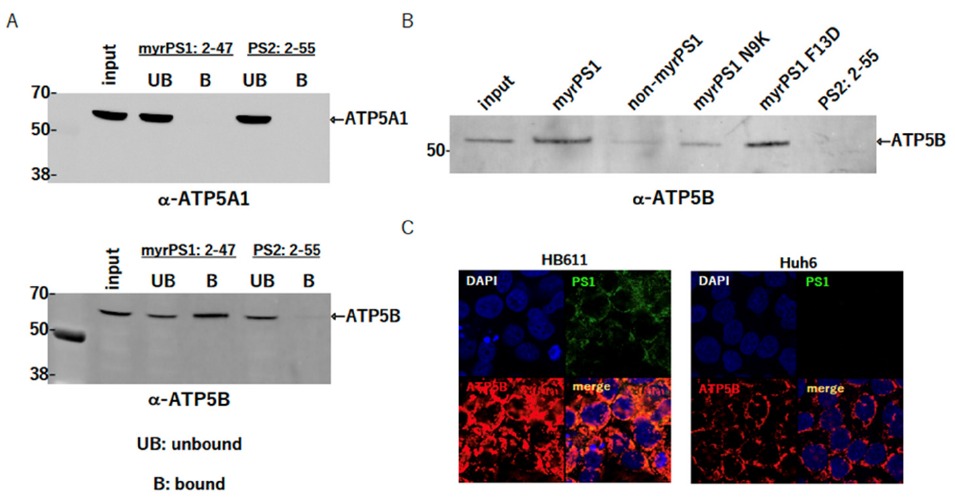
Figure 1. preS1 or preS2 peptide pull-down assay. ( A ). Immunoblot assay of pulled-down samples. Pulled-down samples with myristoylated preS1: 2-47 or preS2:2-55 were blotted either with an anti-ATP5A1 ( upper ) or an anti-ATP5B antibody ( bottom ). ( B ). Immunoblot assay of several kinds of mutant preS1 peptides and preS2 peptides. Pulled-down samples were blotted with an anti-ATP5B antibody. PS1, preS1; PS2, preS2; UB, unbound fraction; B, bound fraction; myr, myristoylated. ( C ). Cellular localization of ATP5B and preS1 (LS). HB611 and Huh6 cells were double-stained with the anti-ATP5B antibody (rabbit) and an anti-preS1 antibody (mouse) followed by Alexa Fluor ® (LI-COR Biosciences, Lincoln, NE, USA) 488-conjugated goat anti-mouse and Alexa Fluor ® 546-conjugated goat anti-rabbit antibodies (LI-COR Bioscicences, Lincoln, Nebraska). Nucleus (DAPI), preS1 (green), ATP5B (red), and the merged images (merge) are shown. The original images were obtained with an × 63 objective lens and with 3-fold